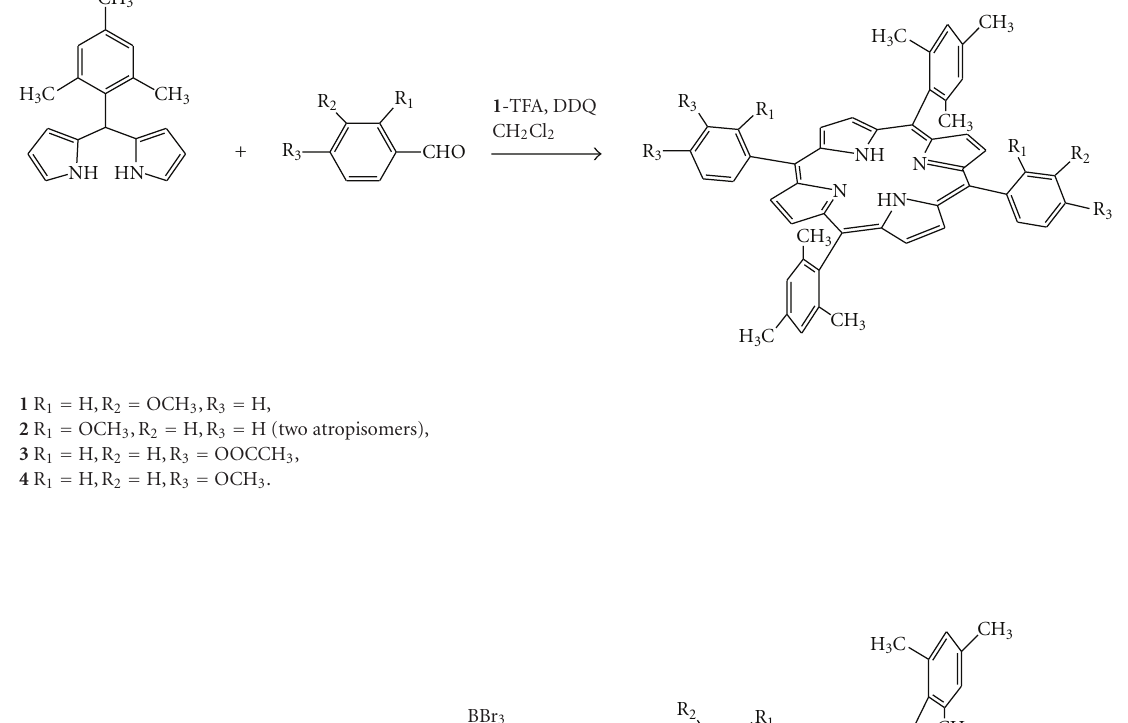
Scheme 1: Reaction scheme.